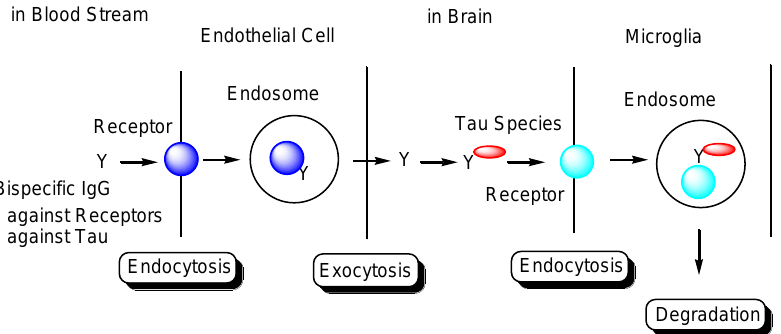
Figure 2. Strategy used to eliminate tau species using anti-receptor and anti-tau bispecific monoclonal antibodies based on receptor-mediated endocytosis and lysosomal degradation in microglia to cure Alzheimer’s disease.